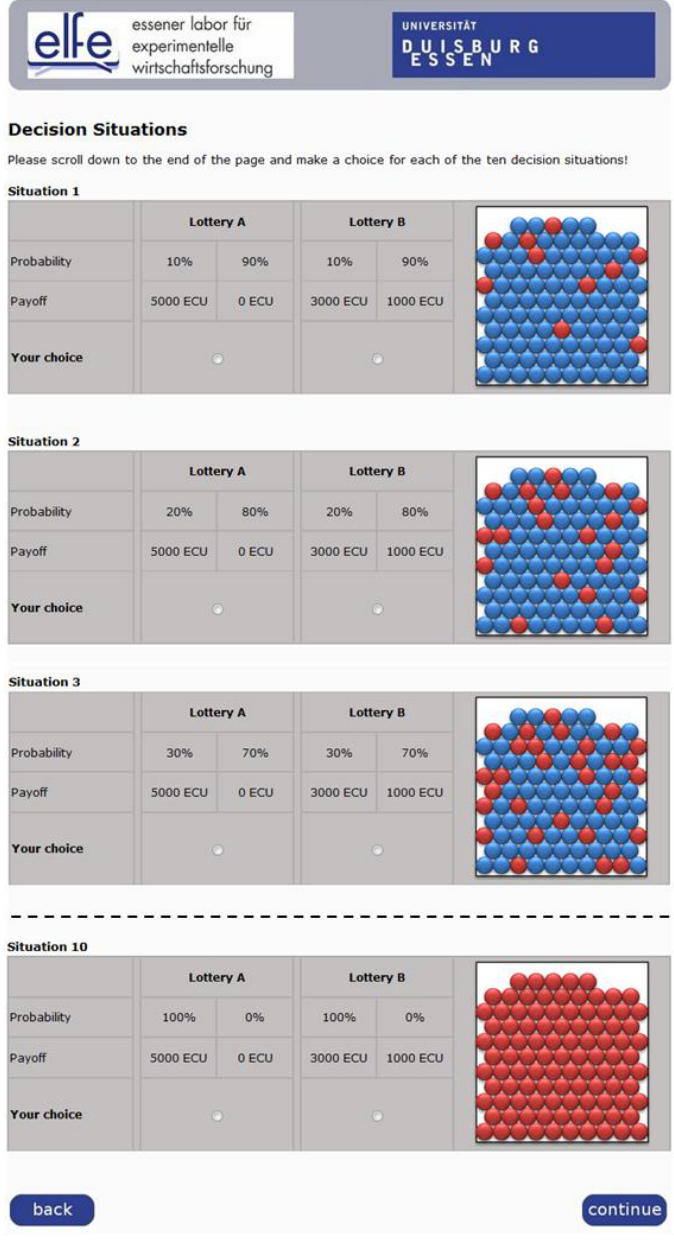
Figure 1. Screenshot (extract) of the online test for risk